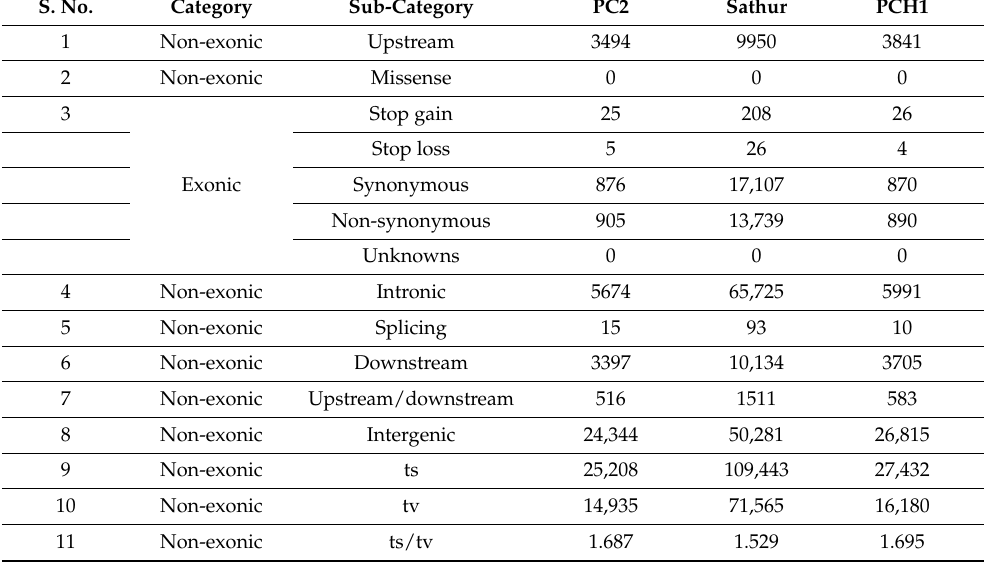
Table 4. Details of SNPs detected among the three investigated lines with respect to the reference